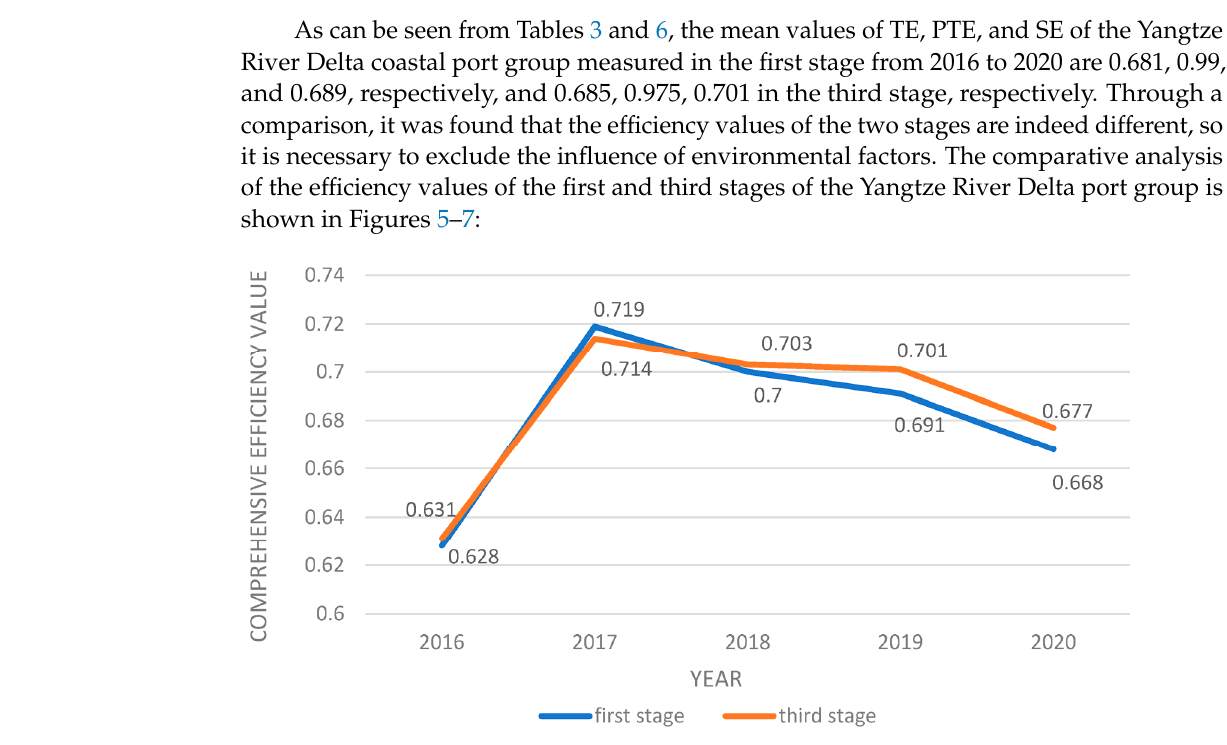
Figure 5. Comprehensive Efficiency Comparison of the Yangtze River Delta Port Groups.